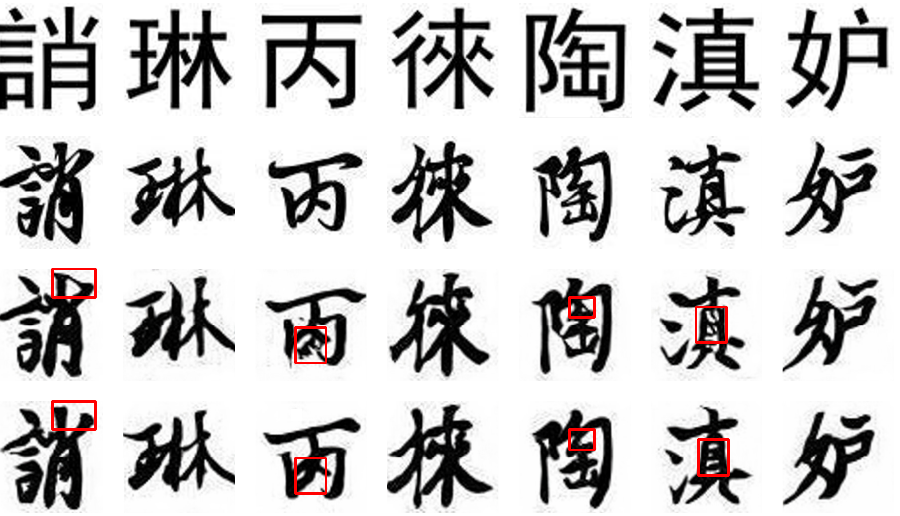
Figure 5. The results of our model with/without Res-SA block evaluated on Wang Xizhi subset. Table 2. Quantitative evaluation of the performance of the model with/without Res-SA block.